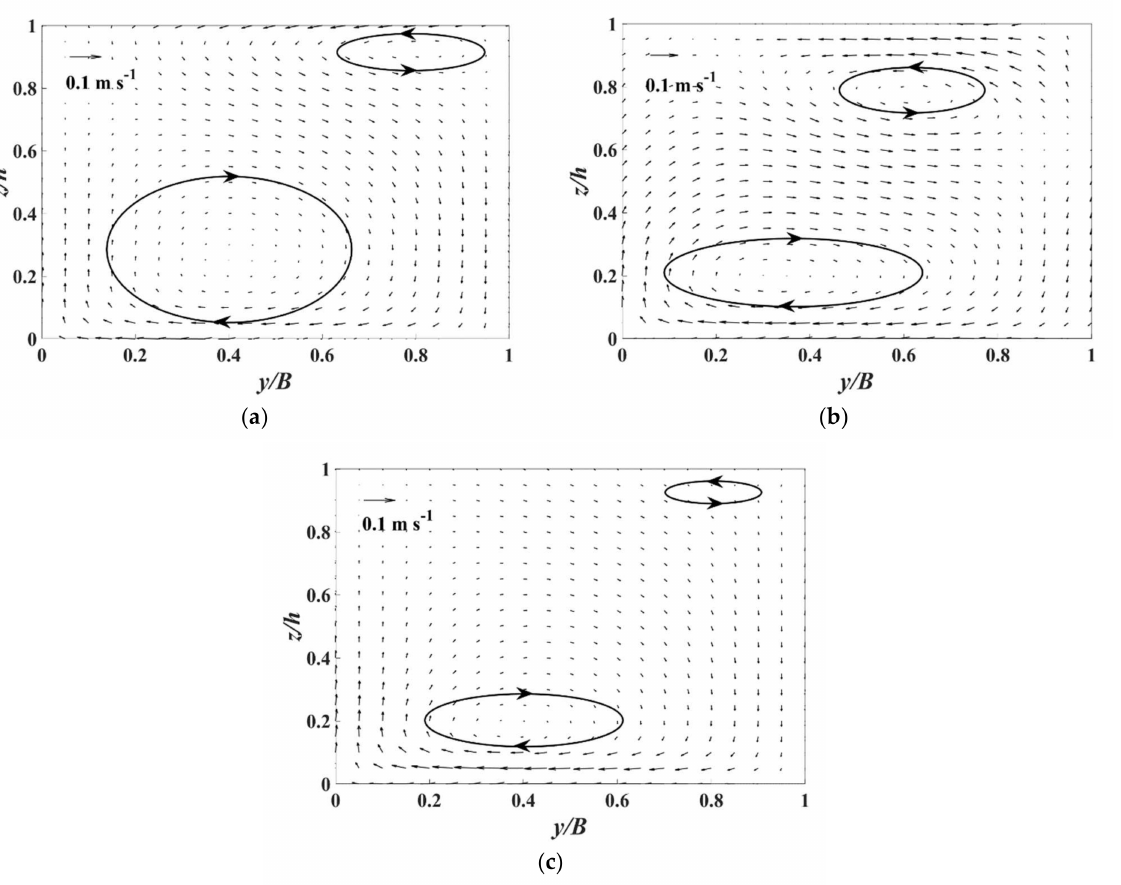
Figure 12. Numerical results of velocity vector for cross-stream motions: ( a ) the bare case, ( b ) the big case, and ( c ) the big case_flat. Note: the arrowed circle represents the secondary